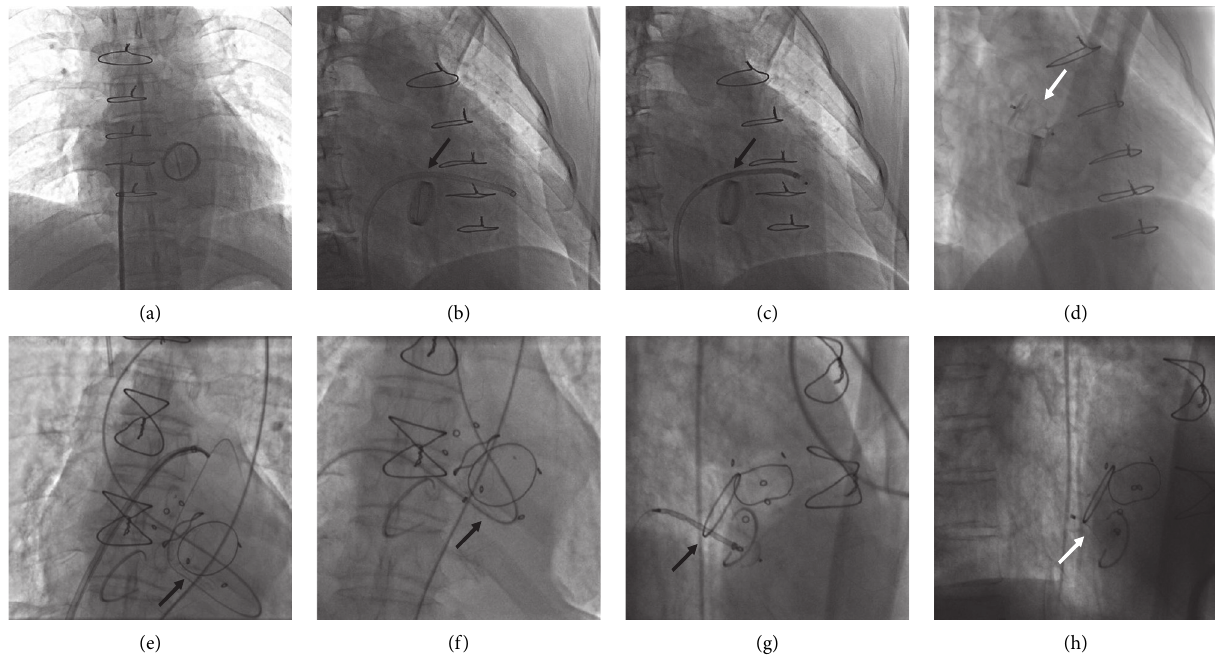
Figure 4: Angiogram taken during the transcatheter closure of the mitral PVL closure via an anterograde transseptal approach and arteriovenous wire loop approach. (a) The femoral venous access was followed by a transseptal puncture. (b) The introducer sheath was advanced into the left ventricle from the femoral vein. (c) The occluder was delivered into the left ventricle. (d) The occluder was deployed. (e) The transseptal puncture was followed by snaring the wire for setting up the arteriovenous loop. (f) The introducer sheath was advanced into the left ventricle via the arteriovenous loop. (g) The occluder was partially placed at the position of the paravalvular leak. (h) The occluder was deployed. The black arrow shows the paravalvular leak. The white arrow shows the occluder.